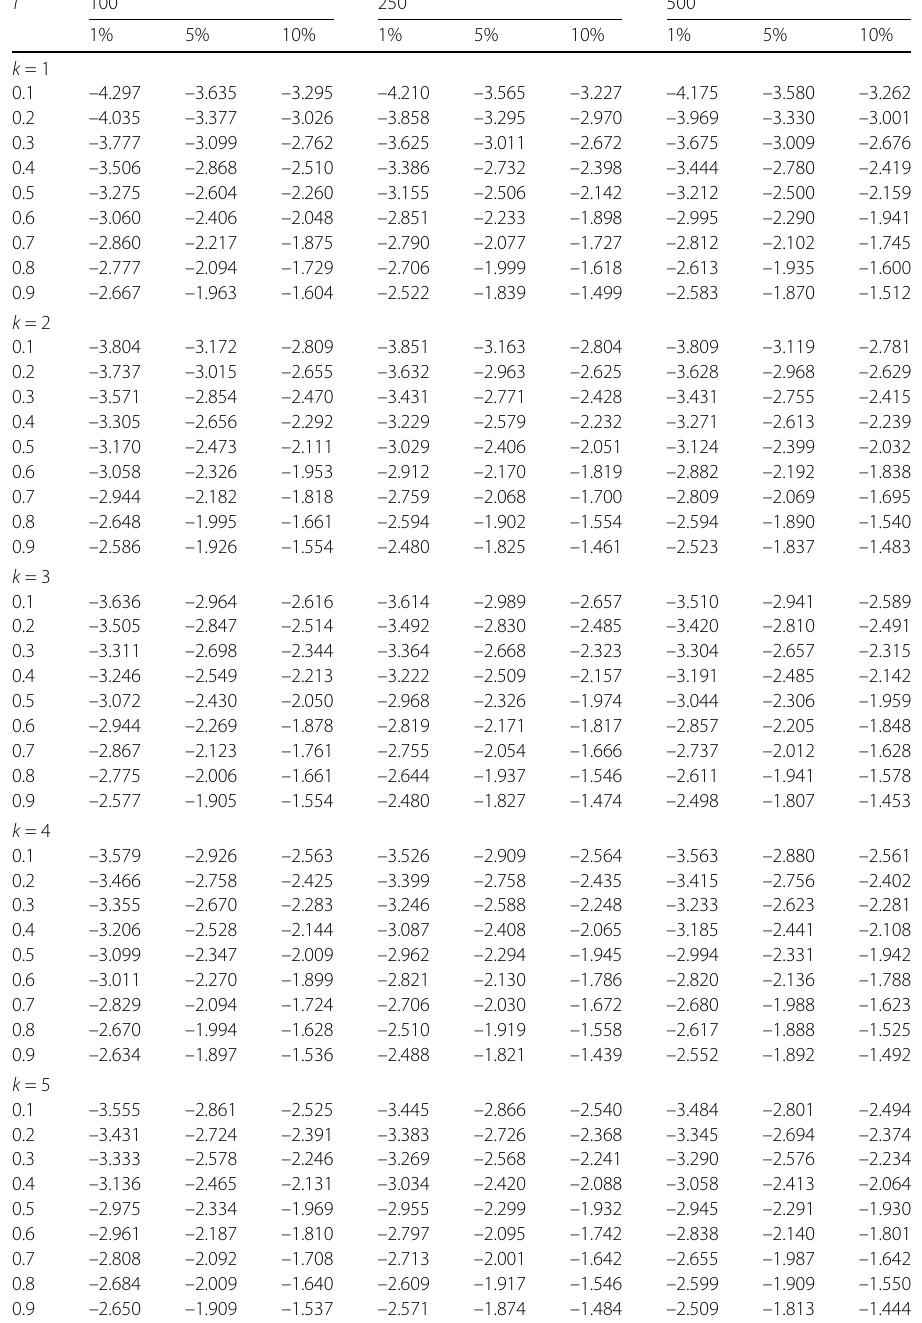
Table 1 Critical values for FI models only intercept included in integer frequency Fourier